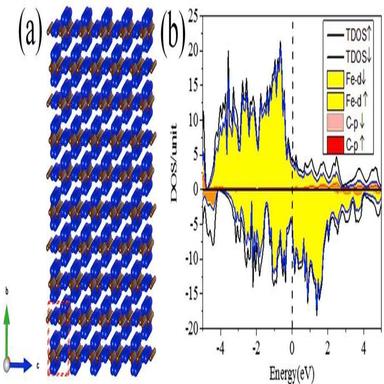
a) Supercell model of Fe3C, b) spin up and spin down project densities of state of the TDOS and partial Fe-d and C-p DOS of the Fe3C bulk phase.